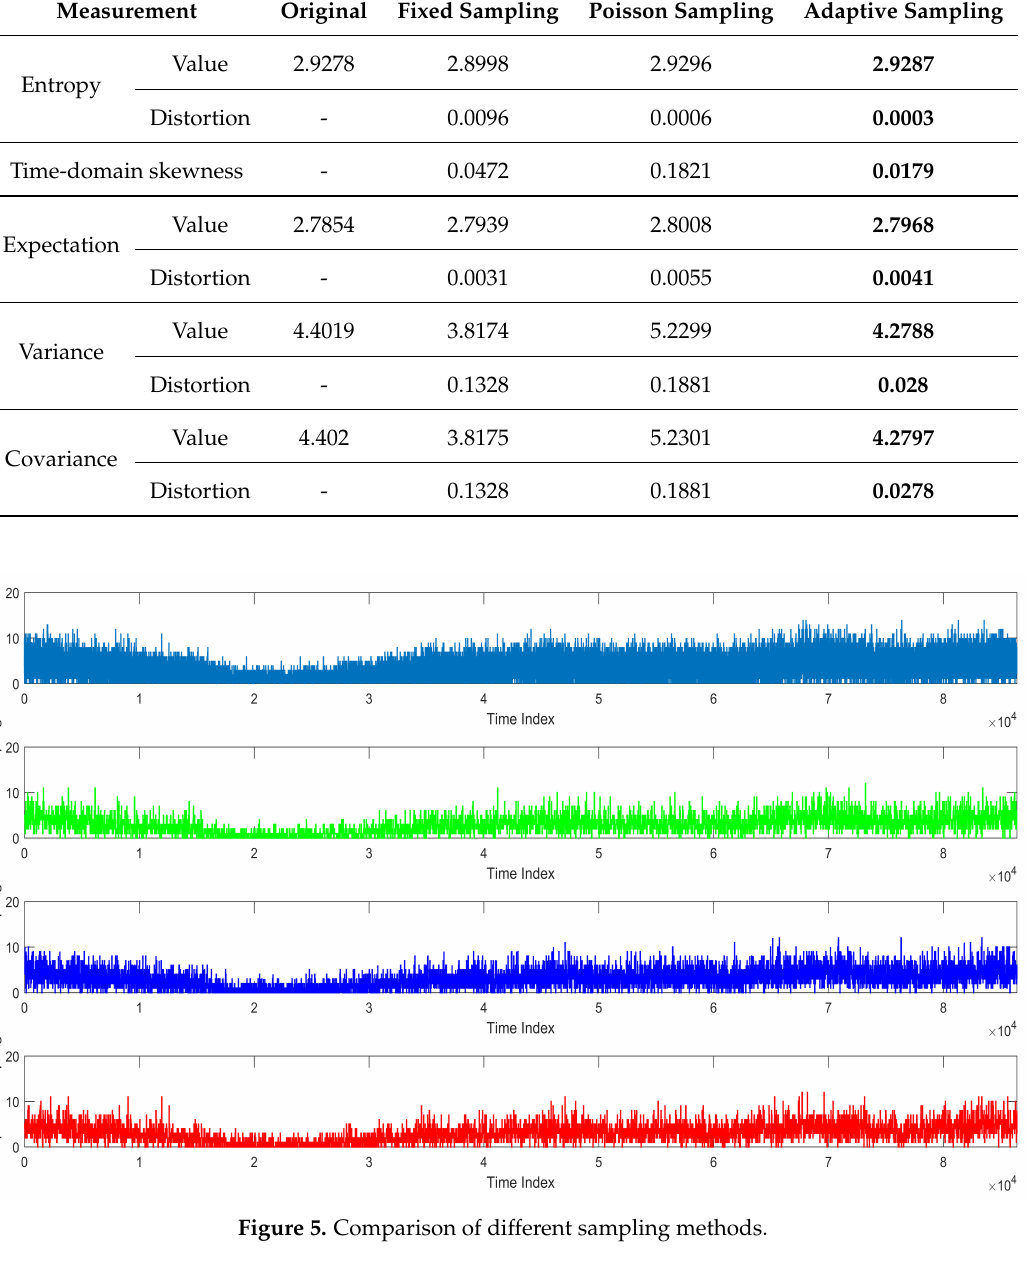
Table 3. Measurement index.